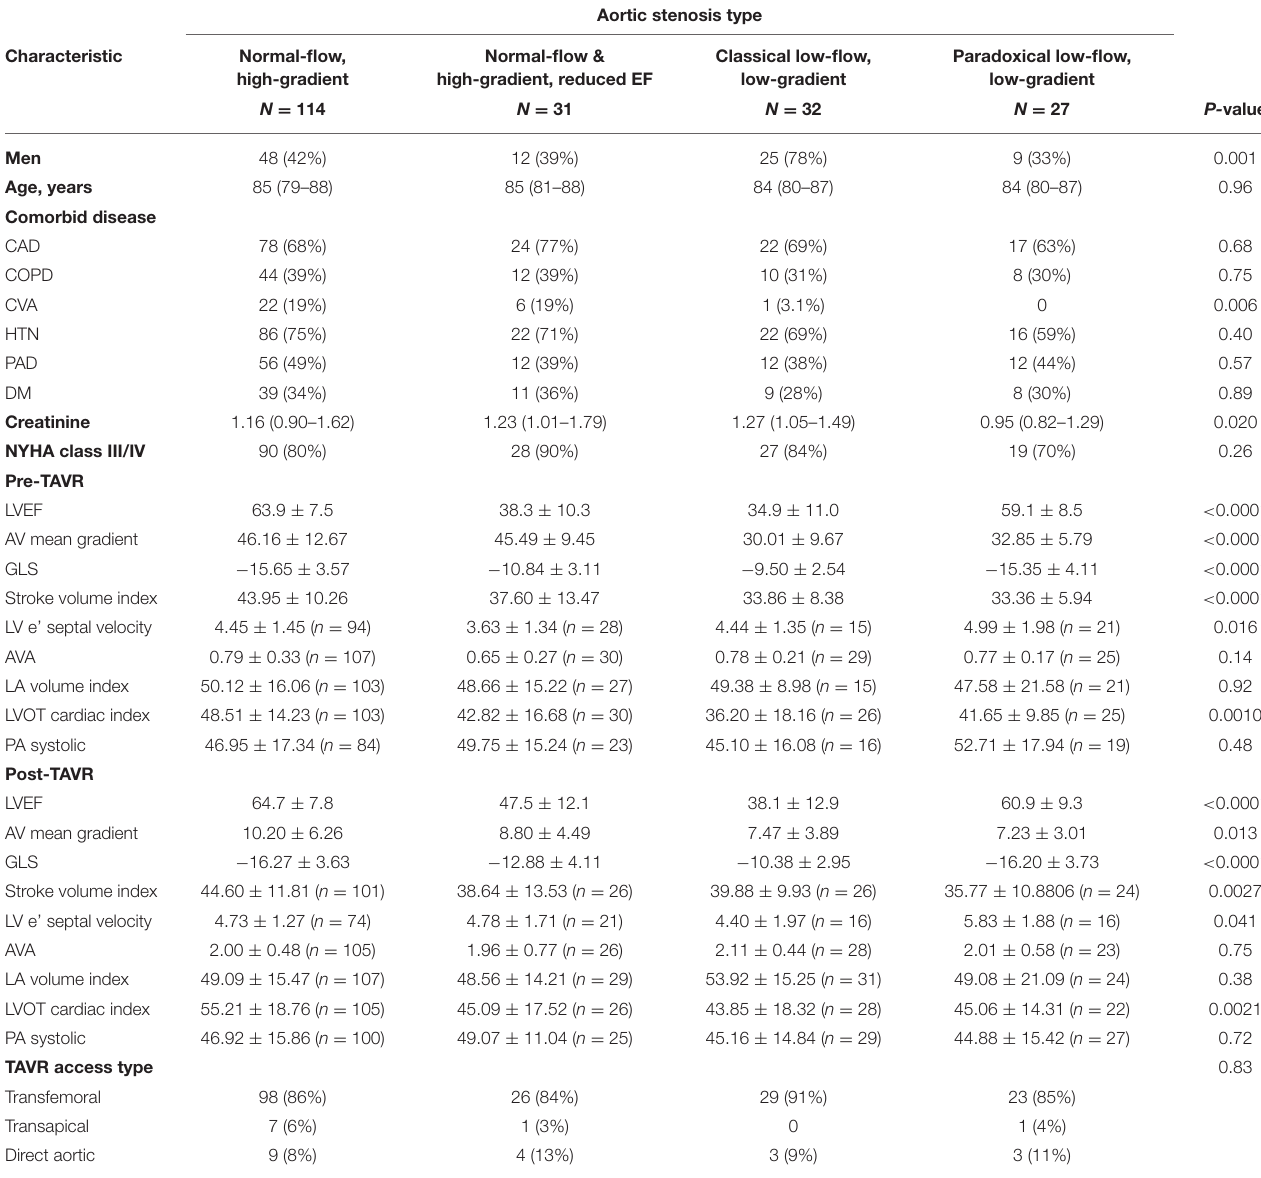
TABLE 1 | Patient characteristics stratified by subtypes of aortic stenosis ( n =